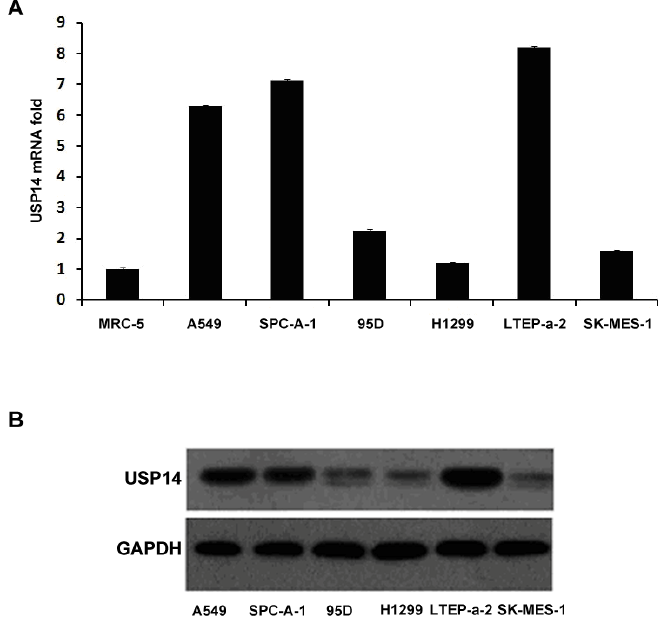
Figure 1. Expression of USP14 in lung adenocarcinoma cell lines. ( A ) Real-time qPCR analysis of USP14 mRNA expression in NSCLC cell lines using human pulmonary epithelial cell line (MRC-5) as normal control. The results were normalized for the amount of GAPDH serving as internal control; ( B ) Western blot analysis of USP14 protein expression in the NSCLC cell lines. GAPDH expression served as internal